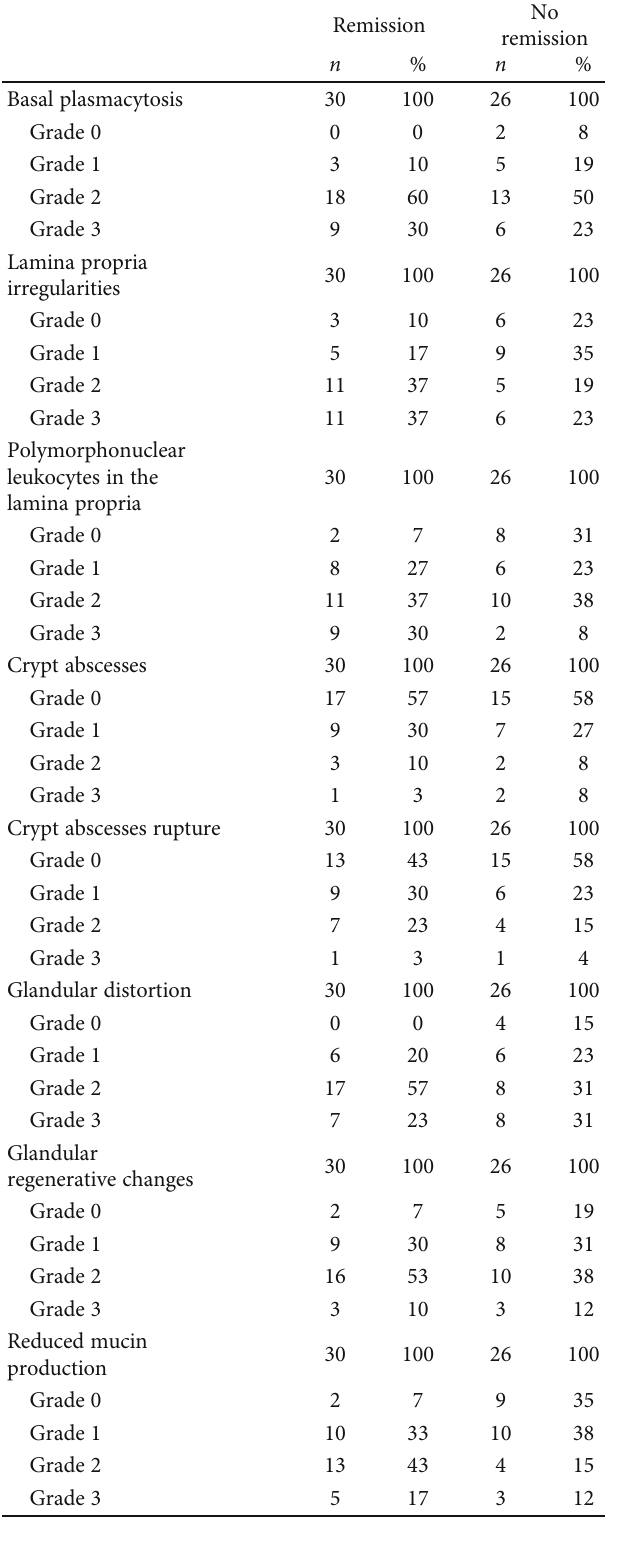
Table 3: Histologic characteristics of mucosal biopsies at diagnosis of ulcerative colitis in patients with documented remission through their clinical